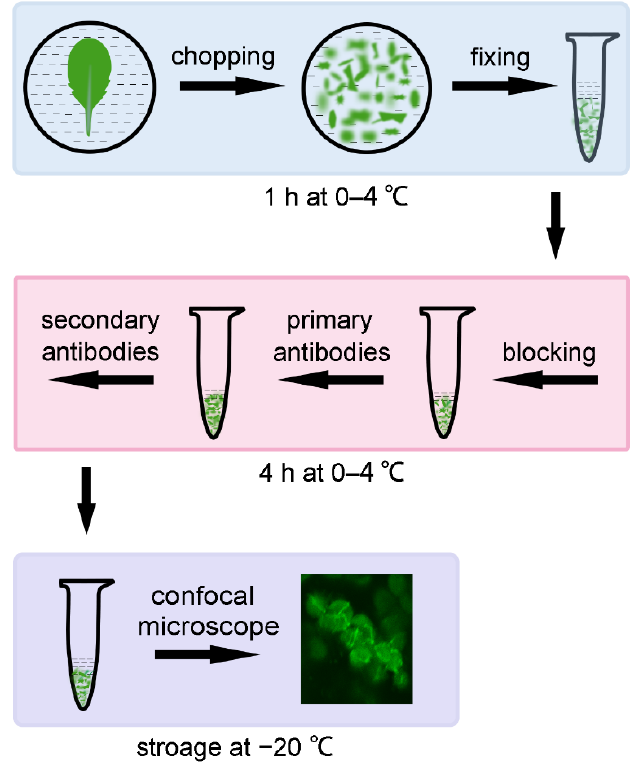
Figure 1. A diagram of the improvements of tissue-chopping-based immunofluorescence staining method. All the steps were operated at low temperature. Leaves were immersed in pre-cooled fixing solution and broken by a serrated blade, then transferred into a 1.5 mL tube and kept in the dark for 1 h for the fixing. After blocking for 30 min, leaf tissues were incubated with pre-cooled anti-FtsZ1 antibodies and then FITC-labeled secondary antibodies. The samples can be stored at − 20 ◦ C for several weeks. Images can be directly observed with a confocal microscope.